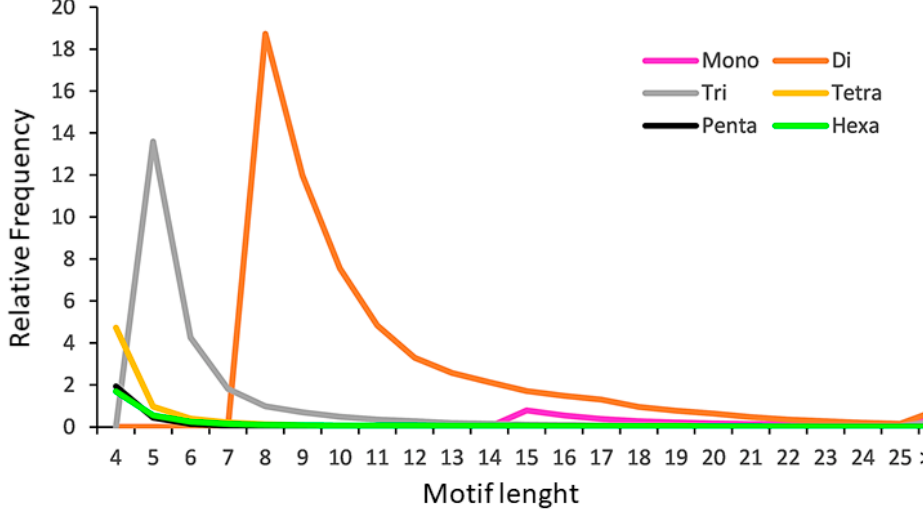
Figure 2. The relative frequency of SSR motifs with different lengths, classified by the number of repeats.